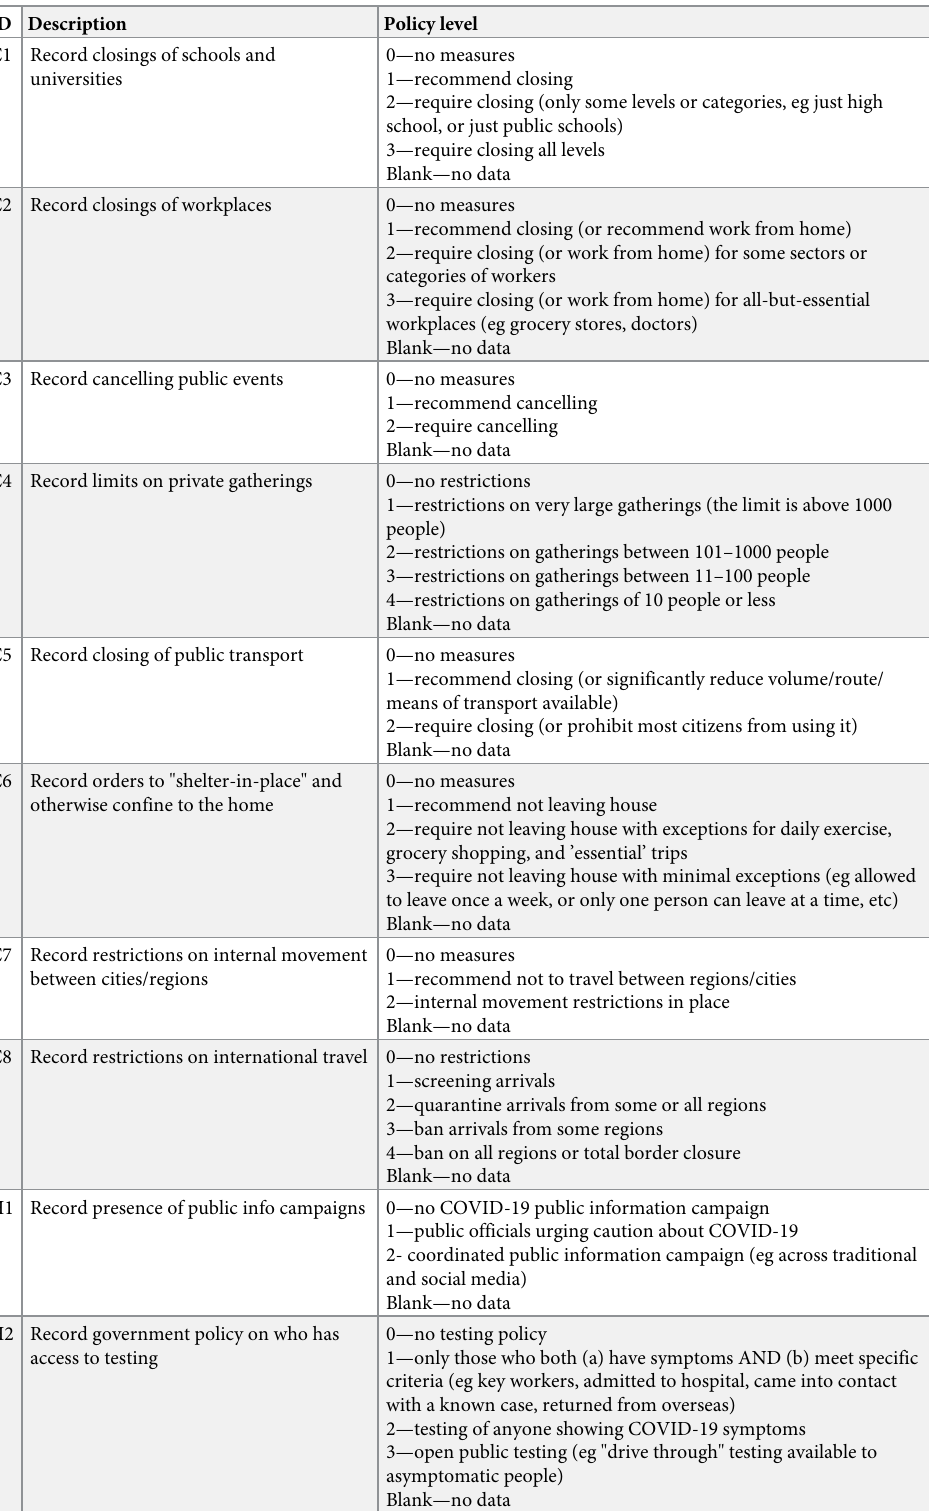
Table 1. Policy coding used in the OxCGRT